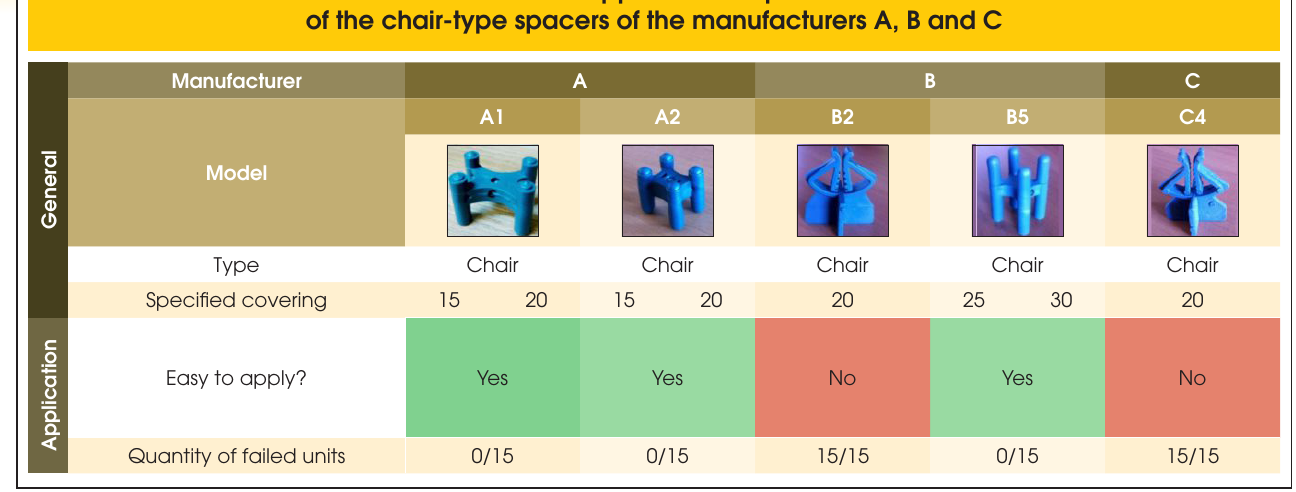
Table 23 – Results of the application requirement evaluation